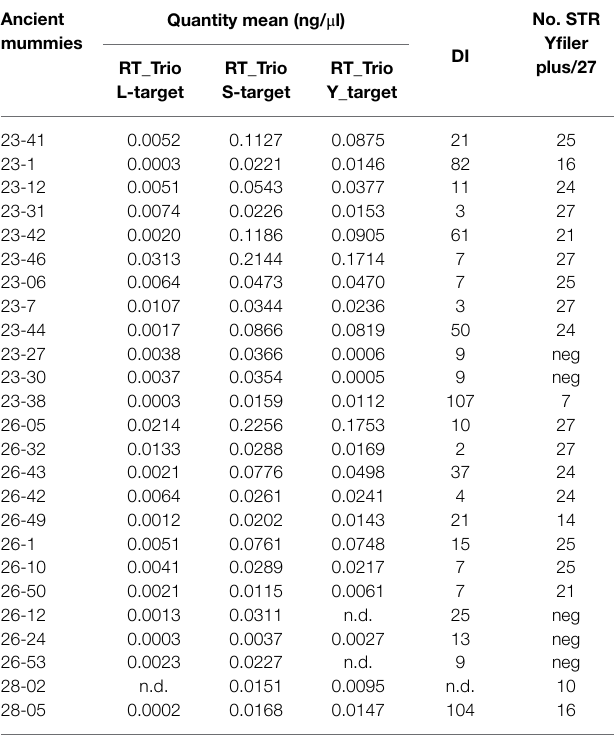
TABLE 2 | Quantification by real-time PCR and Y-chromosome short tandem repeat (Y-STRs) amplification results from the 25 mummies analyzed. Ancient